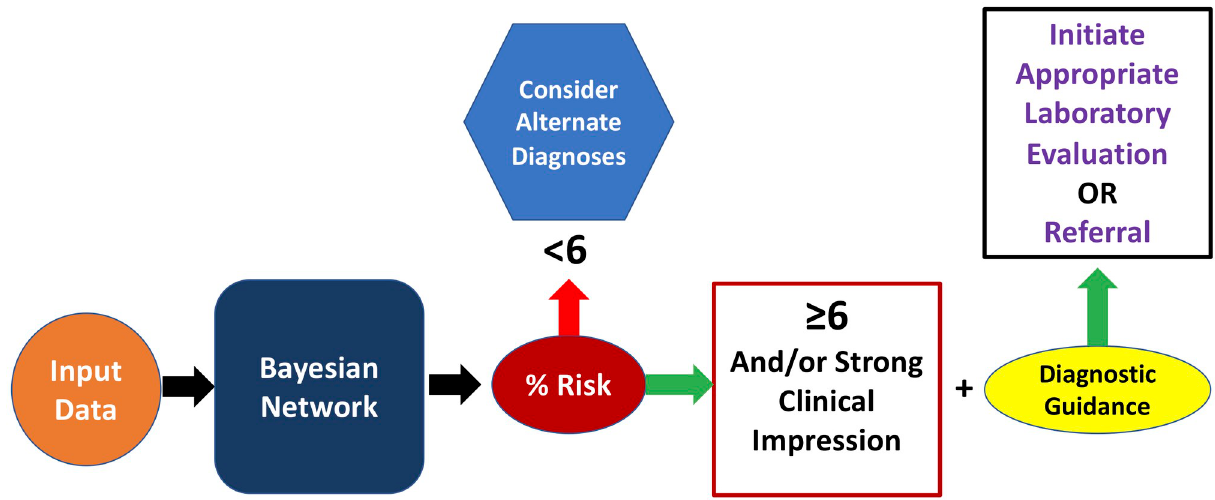
Fig 5. Workflow model. The proposed workflow for our model. Here, an end-user or EHR data feed can provide inputs via clinical impressions or diagnostic codes. The BN calculates a risk score which can subsequently be acted upon. It is important to note that it is the risk score and clinical impression should be taken together, which guide subsequent evaluation and